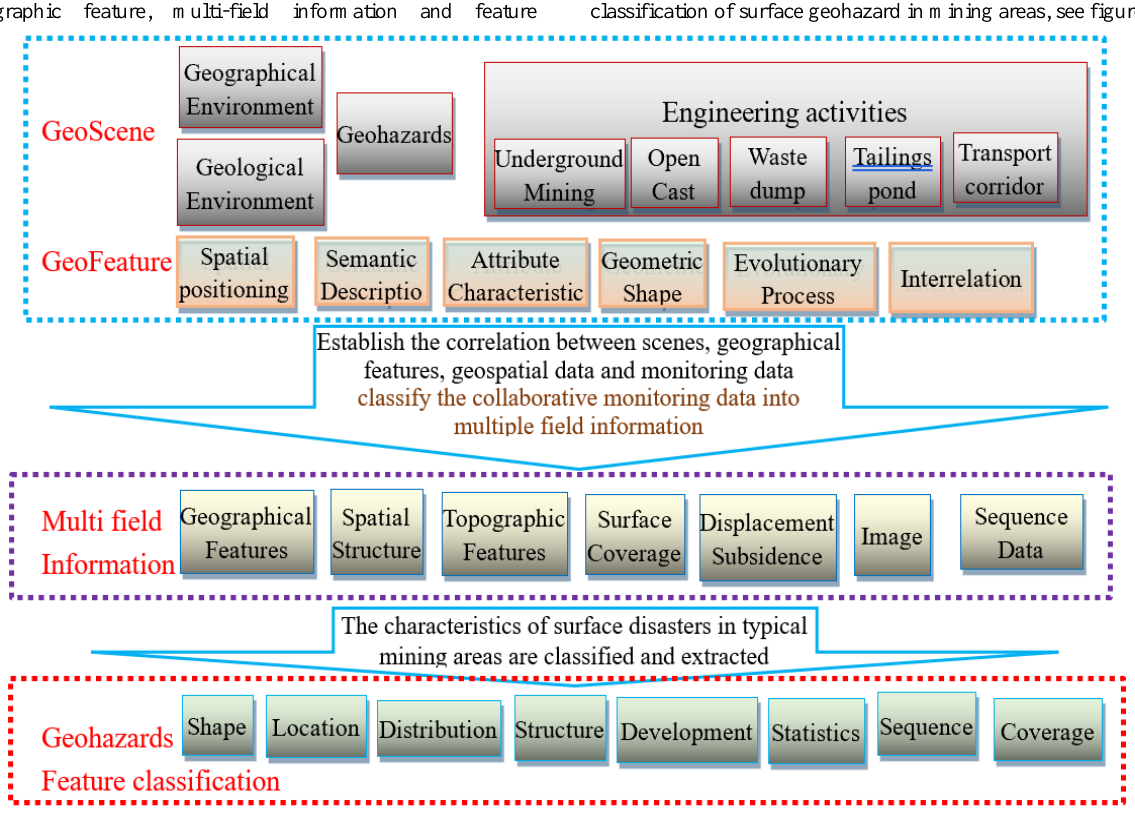
Figure 1. Scene data, geographic feature, multi-field information and feature classification of surface geohazard in mining